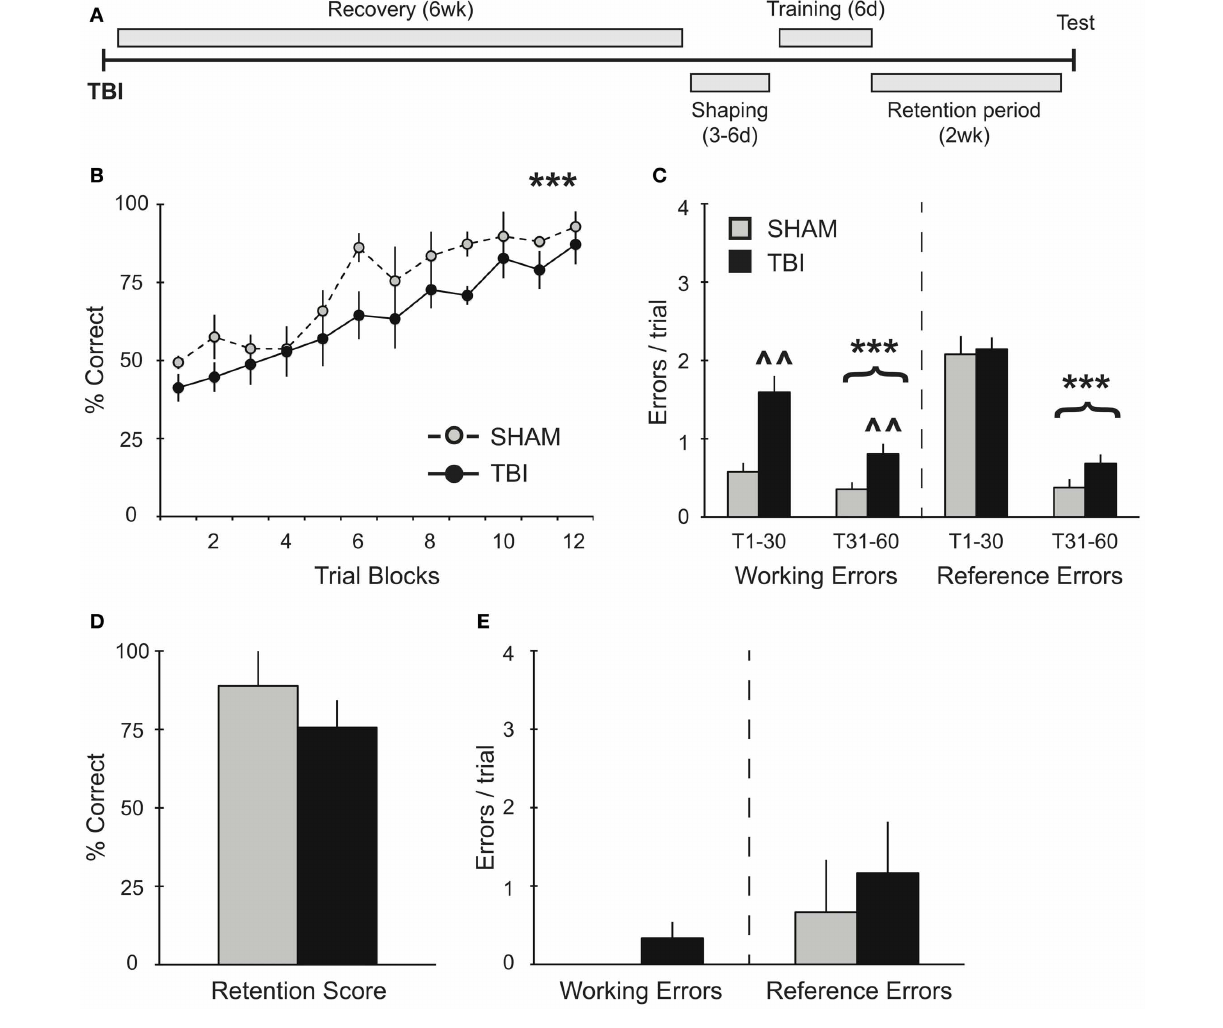
FIGURE 3 | TBI induces working memory deficits during training 6 weeks post-injury but does not impact memory retention. (A) Schematic diagram of the experimental design and timeline for experiment 3. (B,C) During training, there was a significant improvement in percent correct